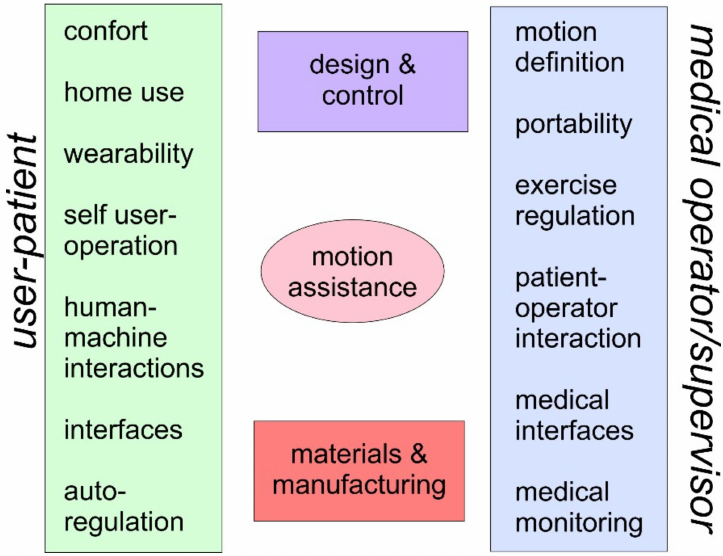
Figure 1. Open issues on motion assistance of the elbow